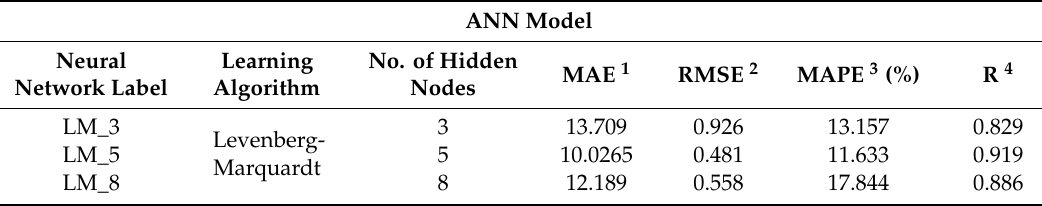
Table 5. Statistical performance of ANN